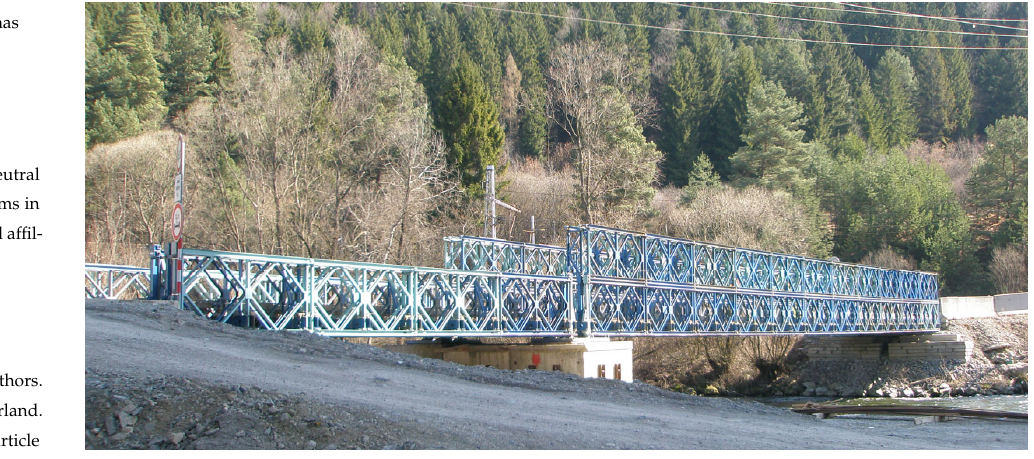
Figure 1. Bailey bridge (TS ‐ 12 + TD ‐ 33) over Vah river during construction (Slovakia).